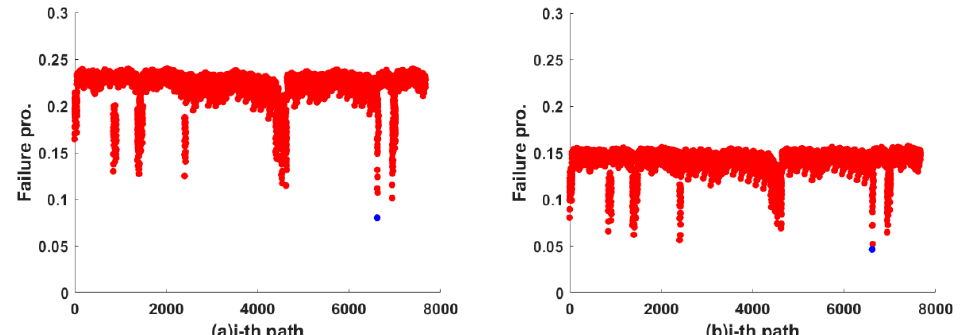
Figure 7. ( a ) Path failure probability between node 1 and node 6 in uniform allocation mode; ( b ) Path failure probability between node 1 and node 6 in non-uniform allocation mode. failure probability between node 1 and node 6 in non-uniform allocation mode.